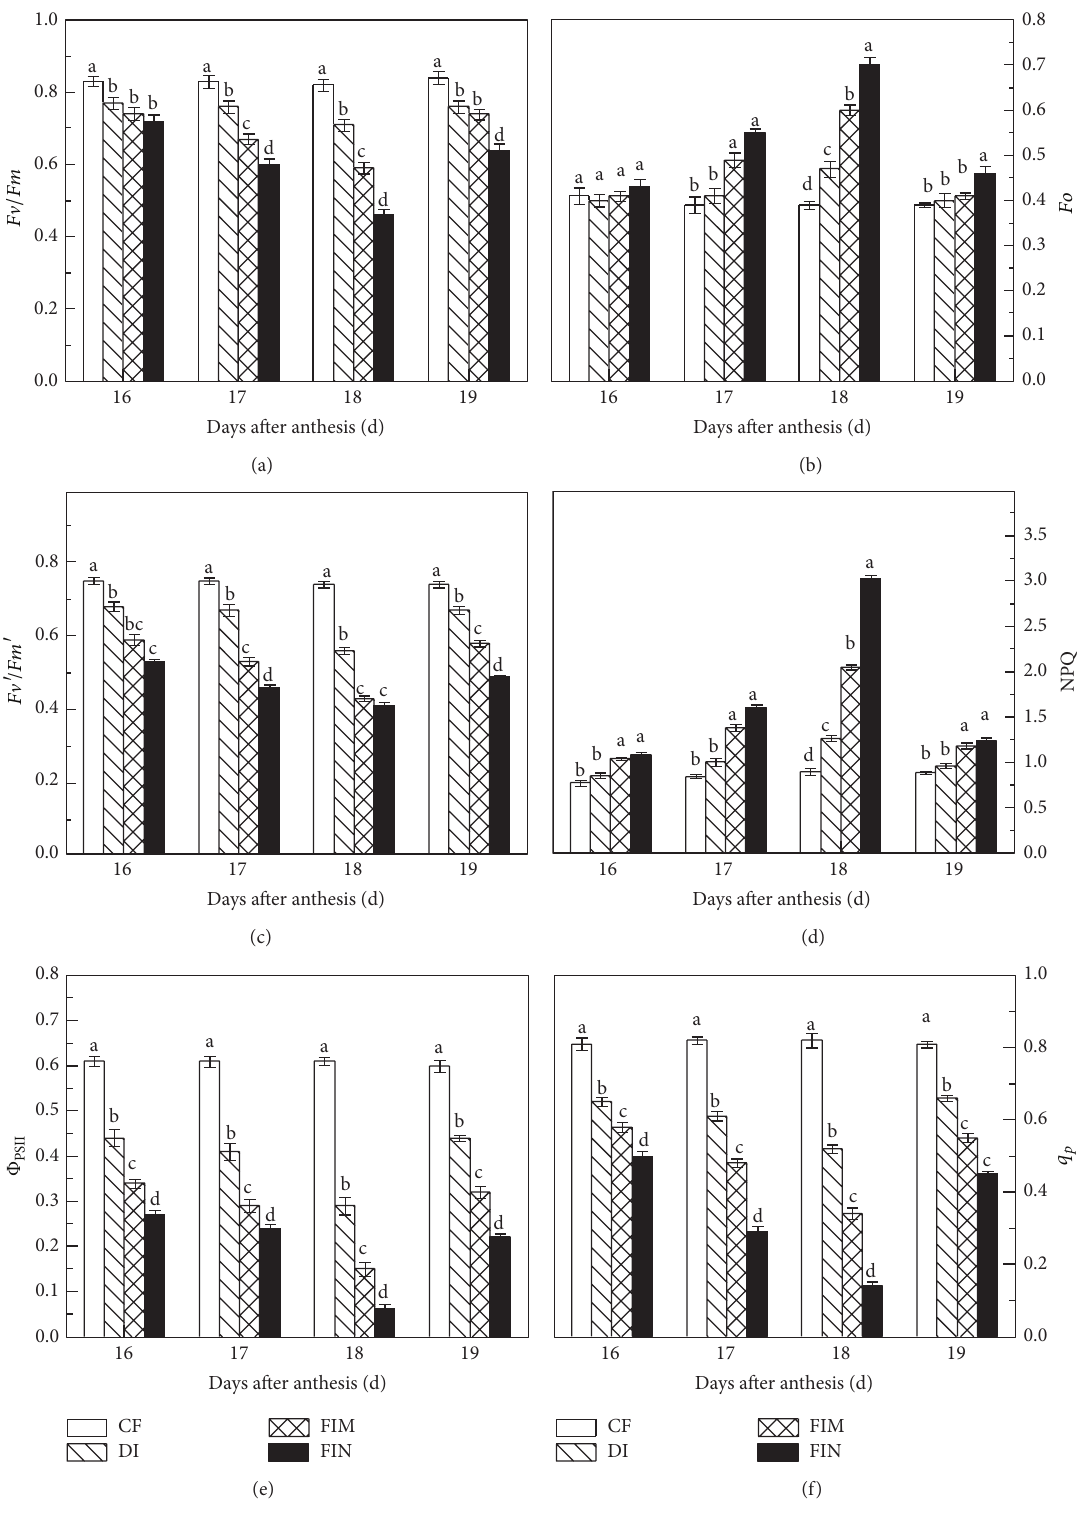
Figure 6: The 𝐹 V /𝐹 𝑚 (a), Fo (b), 𝐹 V 󸀠 /𝐹 𝑚󸀠 (c), NPQ (d), Φ (e), and 𝑞 𝑝 (f) of cultivar Ninggeng28 ( Oryza sativa L.) under different treatments PSII from the 16th day after anthesis to the 19th day after anthesis in Shihezi. The CF indicates conventional flooding, and the DI, FIM, and FIN are plastic film mulching with drip irrigation, plastic film mulching with furrow irrigation, and no mulching with furrow irrigation, respectively. Vertical bars represent SE of the mean; the SE was calculated across five replicates for each year and averaged for the 2 years. Values of each measurement date followed by the same letter indicate no significant differences ( 𝑃 < 0.05 ) according to least-significant-difference